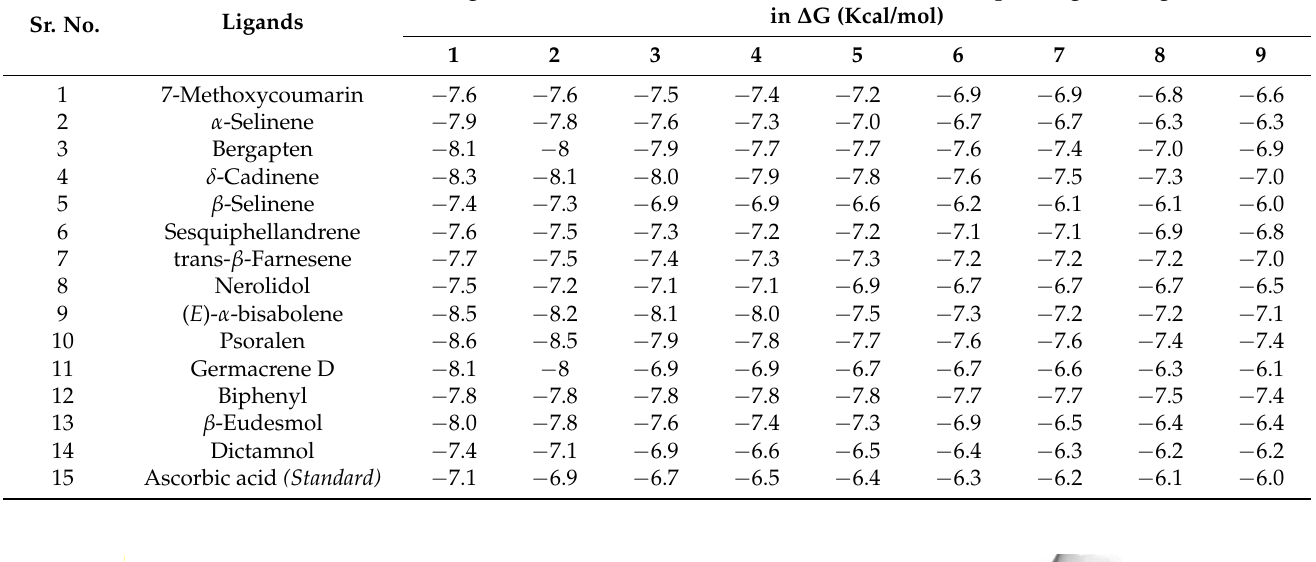
Table 4. Docking score of phytoconstituents at the active site of the receptor NADPH Oxidase. ∆ G (Kcal/mol) Sr. No. in